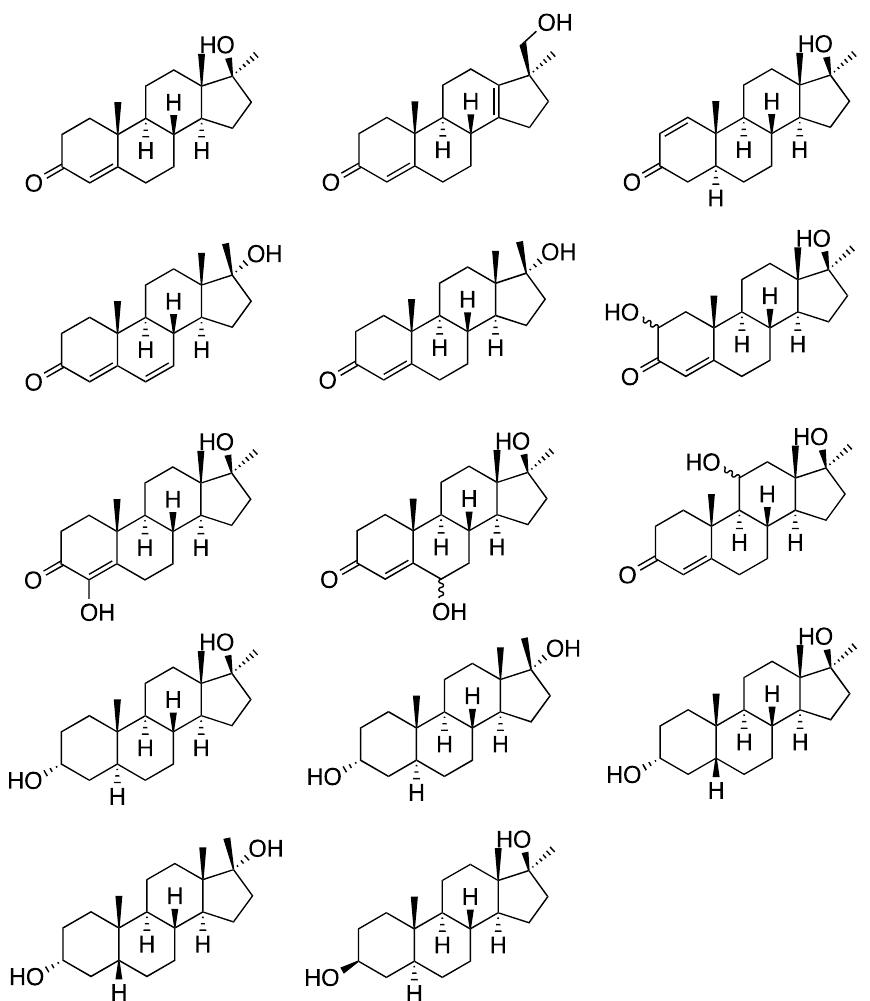
Figure 3. Chemical structures of phase I metabolites of methyltestosterone reported in the literature.